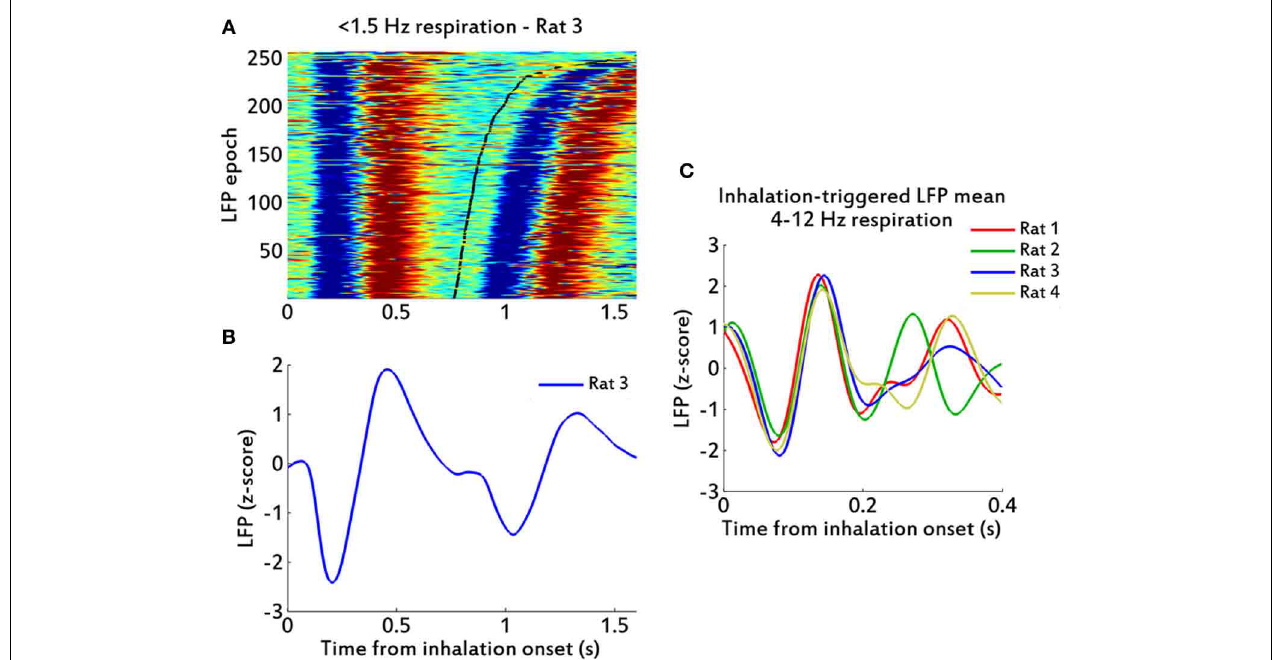
FIGURE 5 | LFP oscillations in low and high frequency respirations. (A) Raster plot of peri-inhalation LFP epochs for rat 3, for slow ( < 1.5Hz) cycles, sorted by respiration cycle duration (shortest at bottom; bottom axis in seconds). Black line marks the ends of the